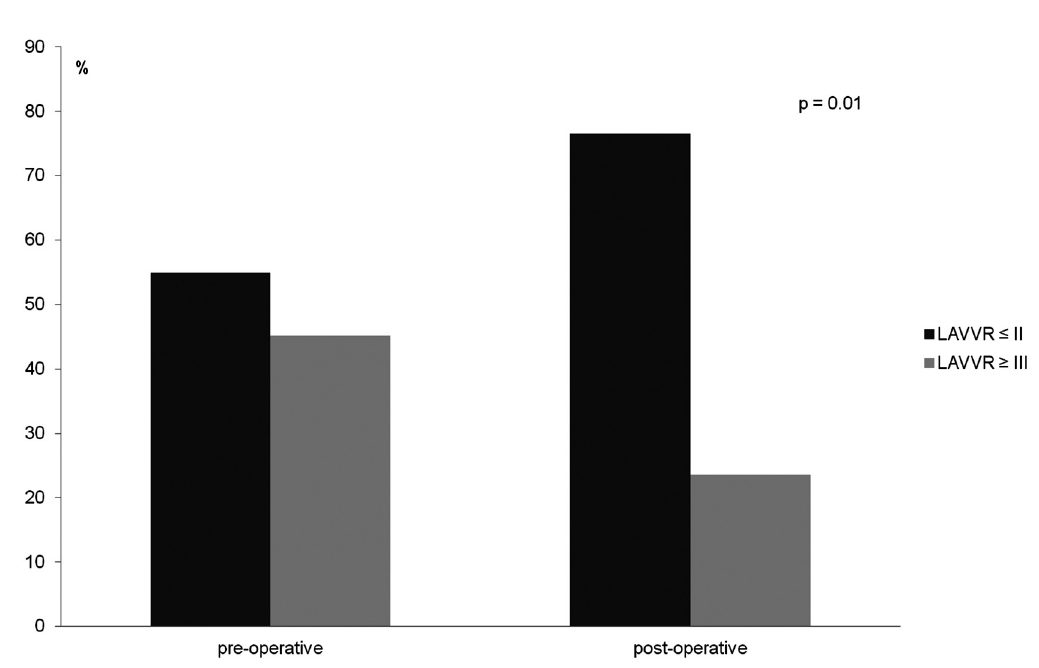
Fig. 1 - Change in left atrioventricular valve regurgitation from pre-operation to